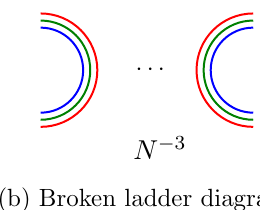
Figure 14. Unbroken and broken ladder diagrams. Unbroken ladder diagram is composed of dipoles of identical color (e.g., D r D r ) while broken ladder diagram contains at least one dipole of distinct color (e.g., D r D b ).